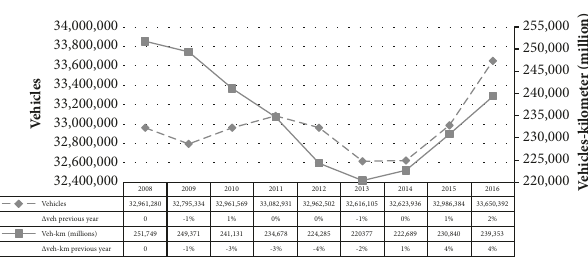
Figure 1: Evolution of vehicle fleet and registered traffic [22,